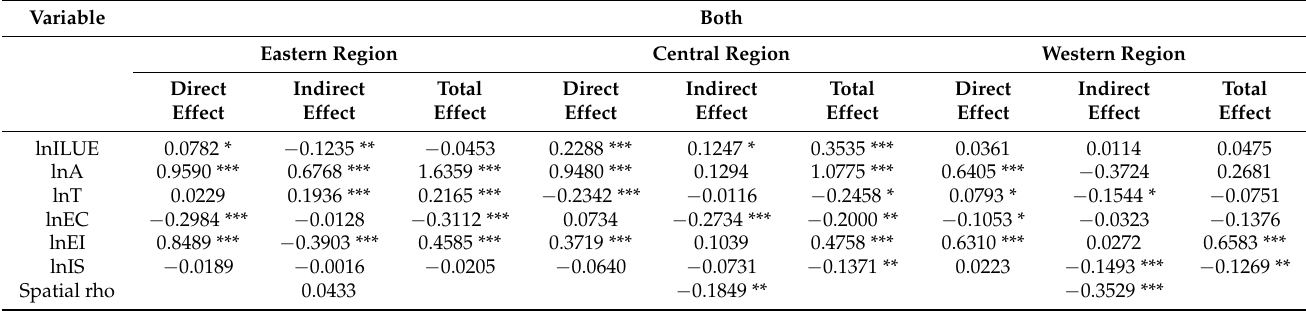
Table 8. Spatial Durbin indirect effect and direct effect of eastern, central and western